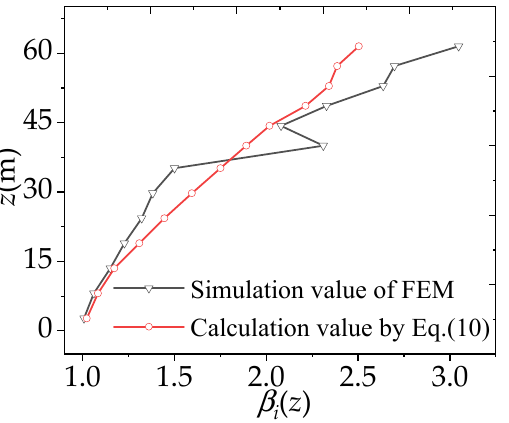
Figure 10. Comparison among different methods of β i ( z ).